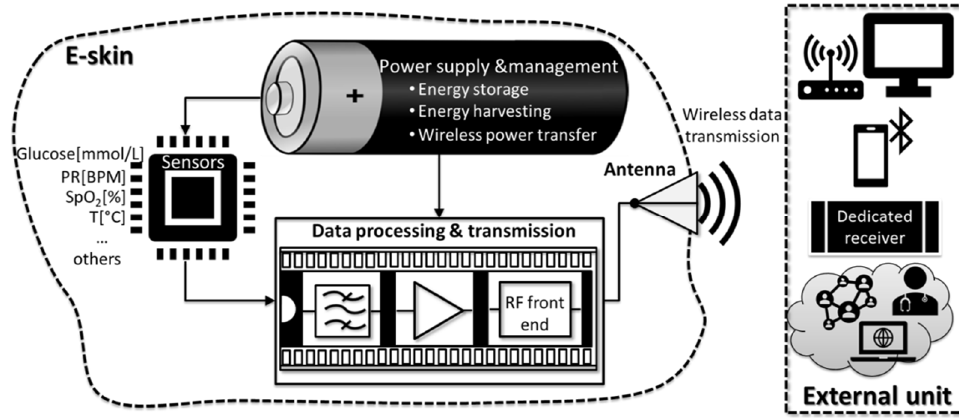
Figure 1. Working principle of an e-skin system.